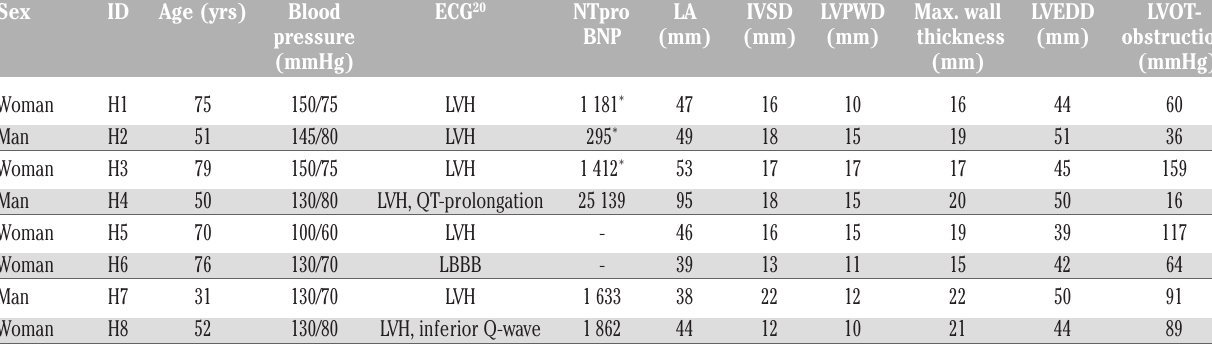
ECG, Electrocardiography; LA, left atrium; IVSD, interventricular septum dimension; LVPWD, left ventricular posterior wall dimension; LVEDD, left ventricular end diastolic diameter; LVOT, left ventricular outflow tract; LVH, left ventricular hypertrophy; LBBB, left bundle branch block. * post myectomy.